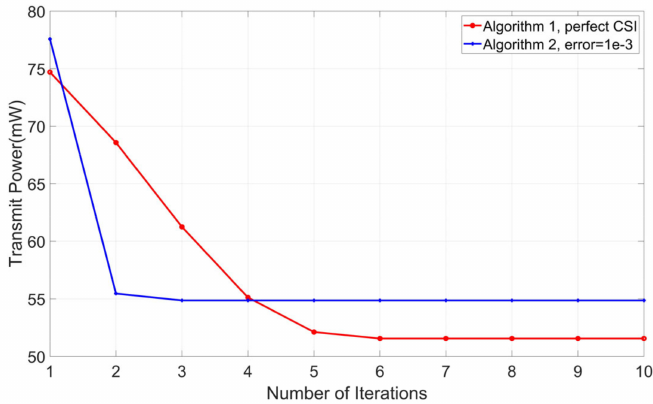
Figure 2. Convergence behavior of the proposed